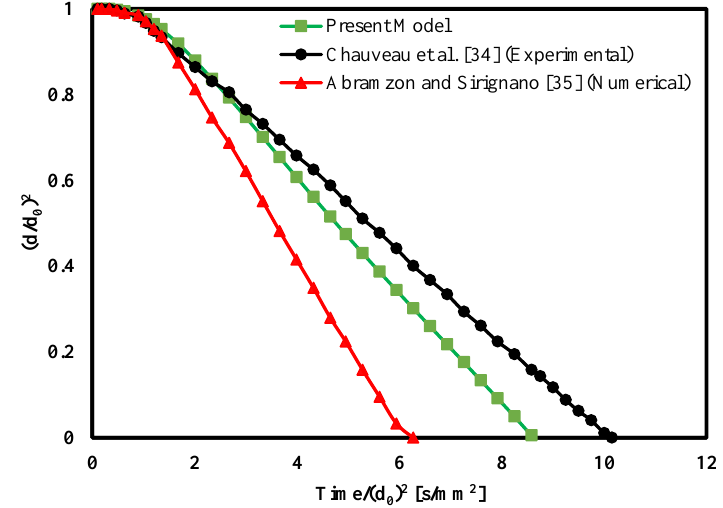
Figure 3. Comparison of n-decane droplet vaporization with the experiments of Chauveau et al. [34] and the model of Abramzon and Sirignano [35].